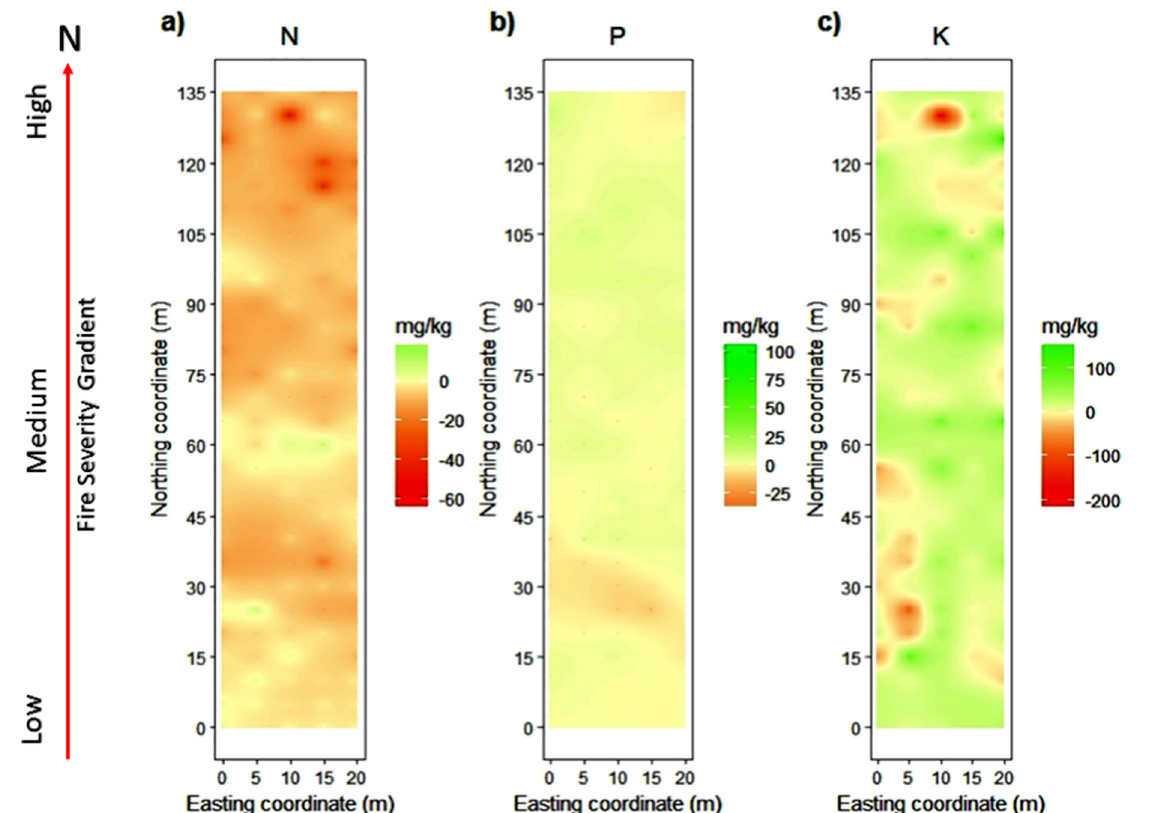
Figure 5. Change in the soil nutrient balance from 2017 to 2018 for ( a ) N, ( b ) P, and ( c ) K within a fire severity gradient from low to high severity. Nutrient concentrations are expressed in mg/kg, and the red arrow indicates the direction in which the fire severity increases through the gradient in the study area.